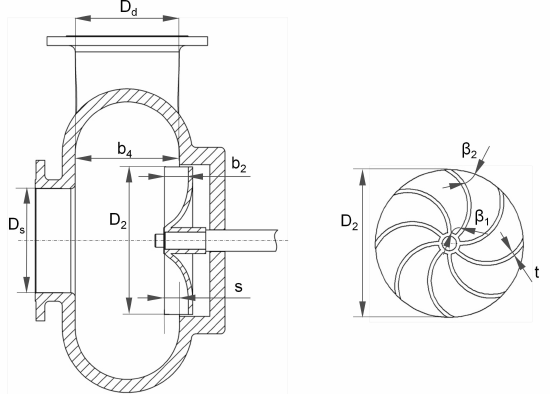
Figure 1. Considered parameters of a vortex pump. Table 1. Assessed parameters in the